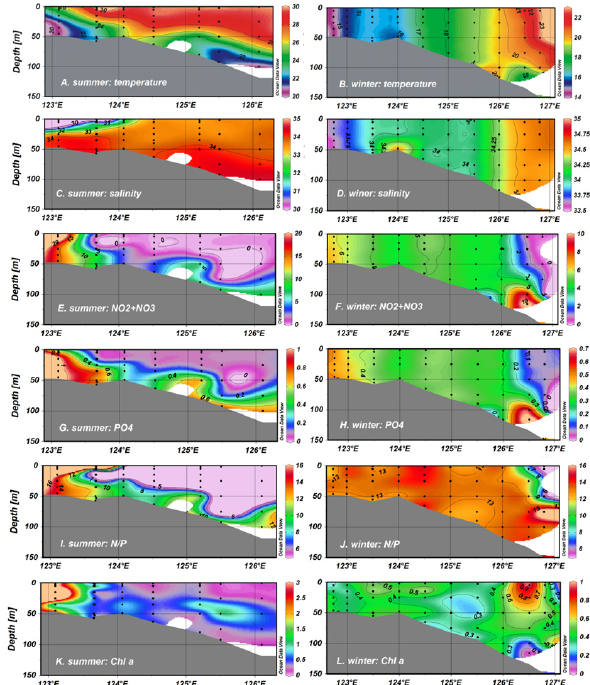
Fig. 3. Vertical distributions of (A, B) temperature, (C, D) salinity (psu), (E, F) NO − +NO − concentration (µgL − 1 ), (G, H) PO 3 − 3 2 concentration (µgL − 1 ), (I, J) N/P, and (K, L) Chl a concentration (µgL − 1 ) in summer and winter along PN